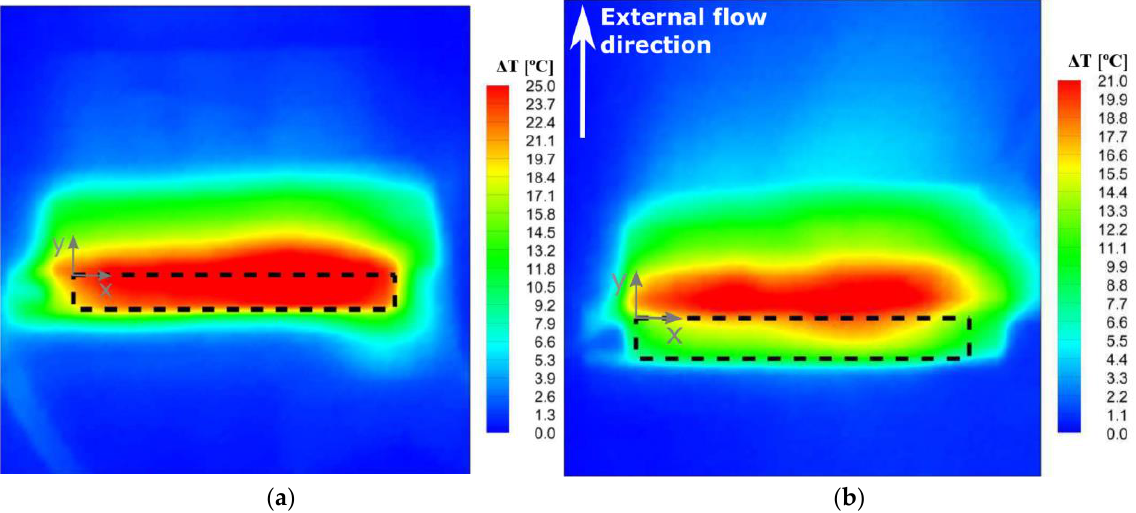
Figure 8. Typical surface temperature field of a dielectric barrier discharge plasma actuator with a dielectric thickness made of Kapton, 1 mm thick, operating at 8 kVpp and 24 kHz: ( a ) quiescent conditions ( b ) under external flow influence (reproduced from Rodrigues et al. [167] with permission of Elsevier).